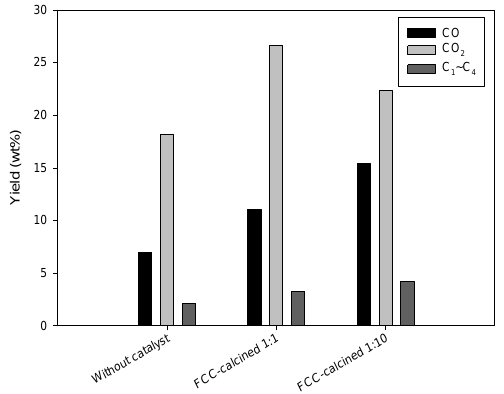
Figure 9. Detailed species distributions of gas obtained from non-catalytic and catalytic pyrolyses of wild reed.